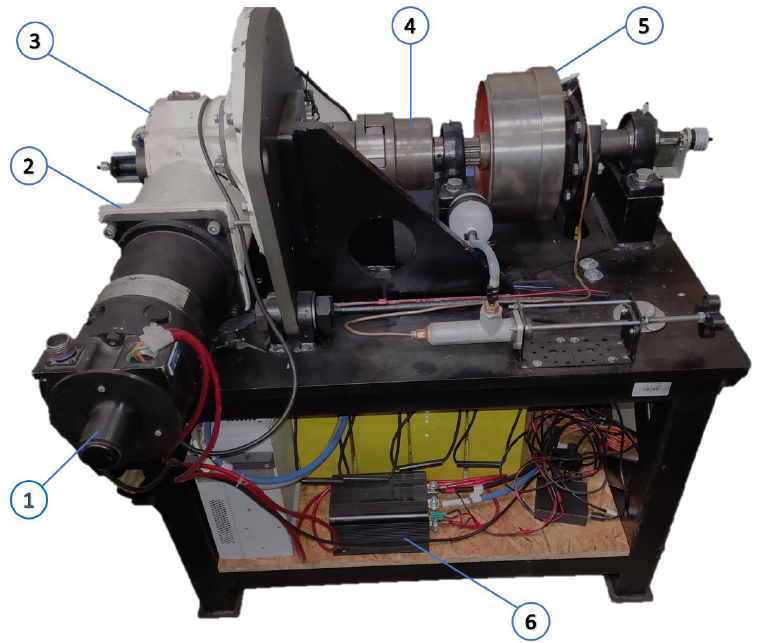
Figure 8. Test bench; 1—engine 1, 2—body, 3—spiroid gear, 4—coupling, 5—brake, and 6—measuring unit. Temperature in the face gear rim is measured with the use of thermocouples. The thermocouples were mounted in six holes evenly spaced around the circumference made on the front side of the face gear. The location of thermocouples is presented in Figures 9 and 10.